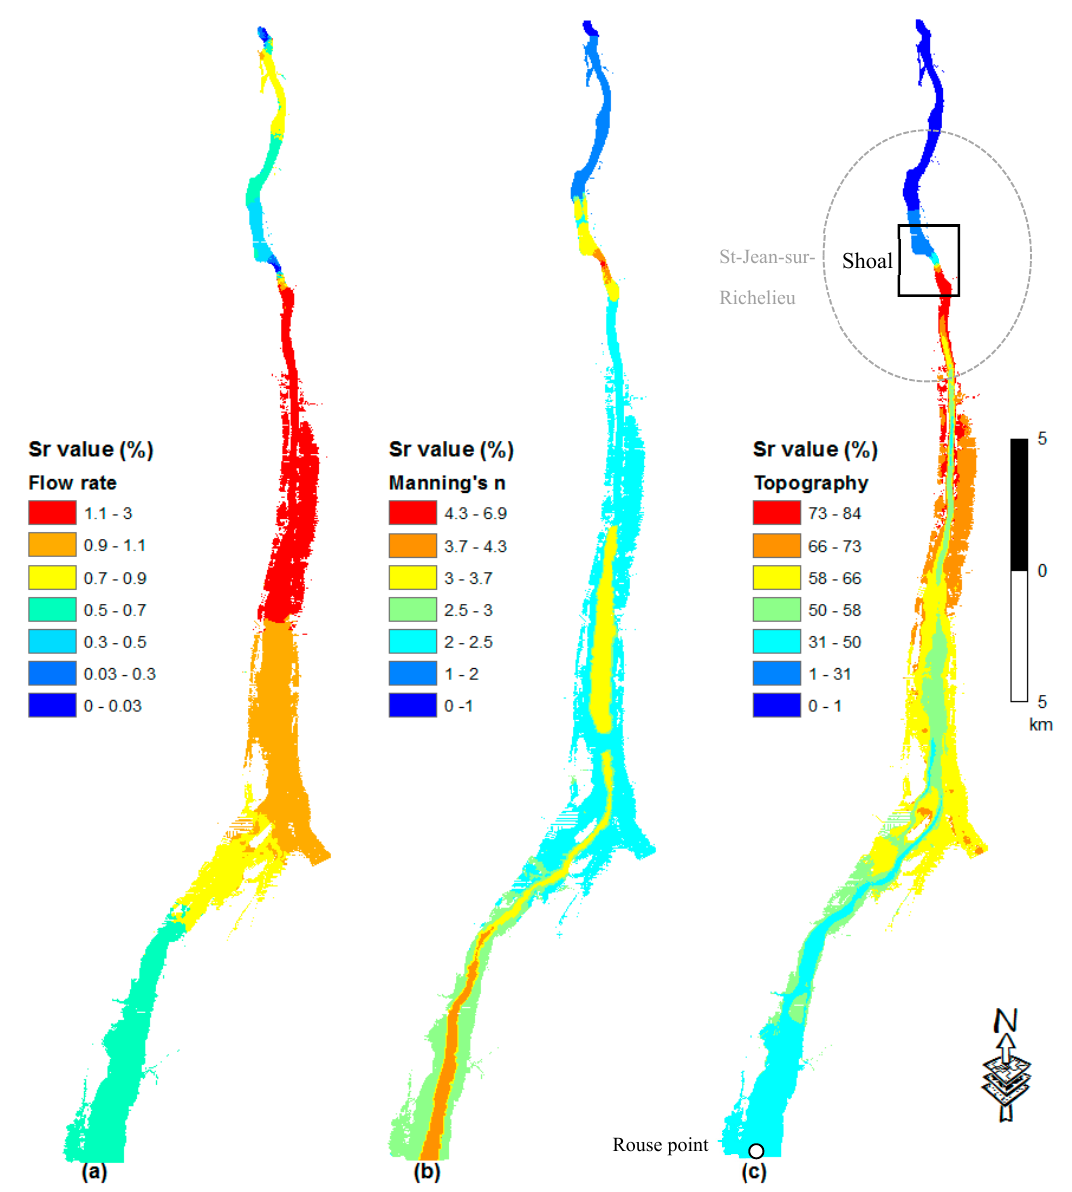
Figure 7. Sensitivity of the simulated flow depths to each of the three input variables, ( a ) flow rate Sr ( X 1 ) , ( b ) Manning’s n coe ffi cient Sr ( X 2 ) , and ( c ) topography Sr ( X 3 ) , for nominal flow rate of 936 m 3 s⁄ .